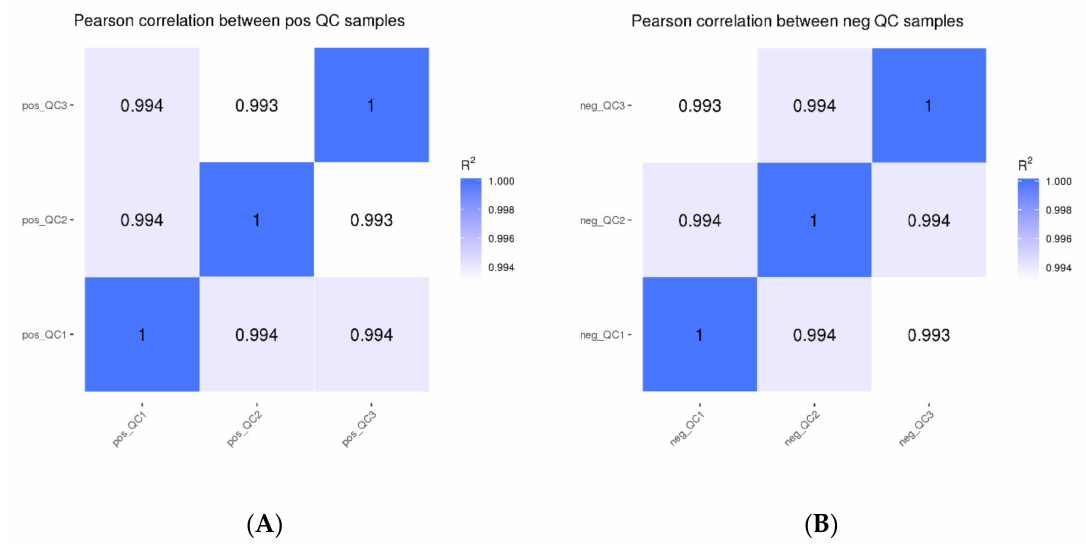
Figure 1. Correlation analysis of QC samples (( A ): positive mode; ( B ): negative